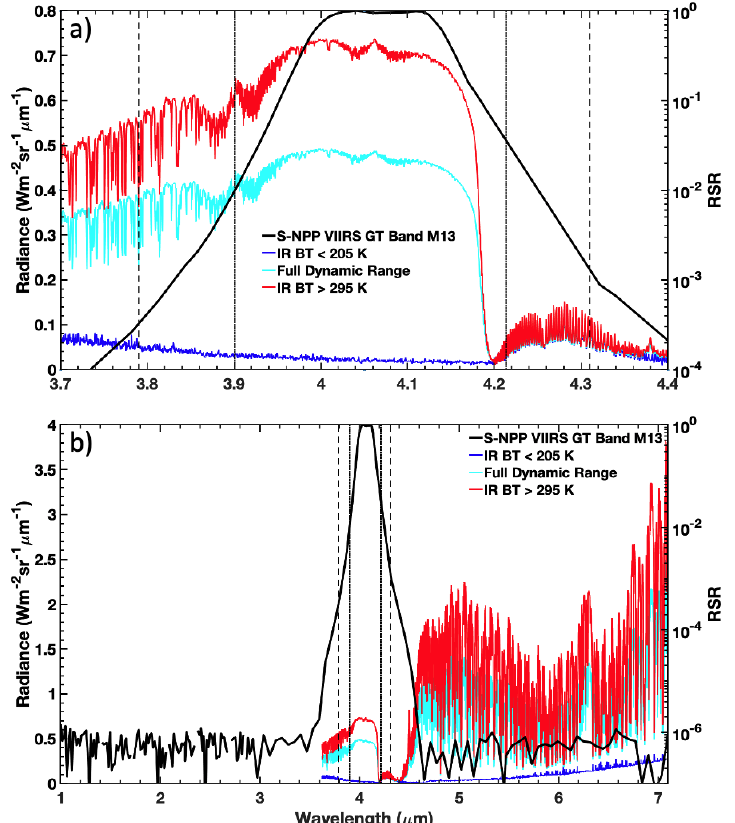
Figure 7. ( a ) Same as Figure 4, except with S-NPP VIIRS GT Band M13 RSR overlaid with IASI Earth-reflected (day only) and Earth-emitted (day and night) radiance for hyperspectral footprint measurements where Aqua MODIS 11- µ m band-integrated IASI IR BT is less than 205 K, is greater than 295 K, and with no BT limit specified (i.e., full dynamic range). ( b ) Rescaled version of (a) with broader x-axis, left y-axis, and right y-axis limits in order to reveal the full OOB measurement range of S-NPP VIIRS GT band M13. Note that 3.6 µ m is the lower wavelength limit of